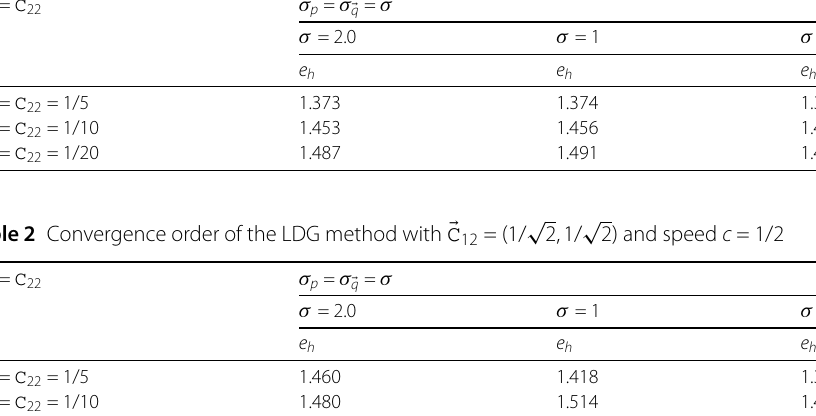
Table 1 Convergence order of the LDG method with (cid:3) C 12 = (1,1) and speed c = 1 C 11 = C 22